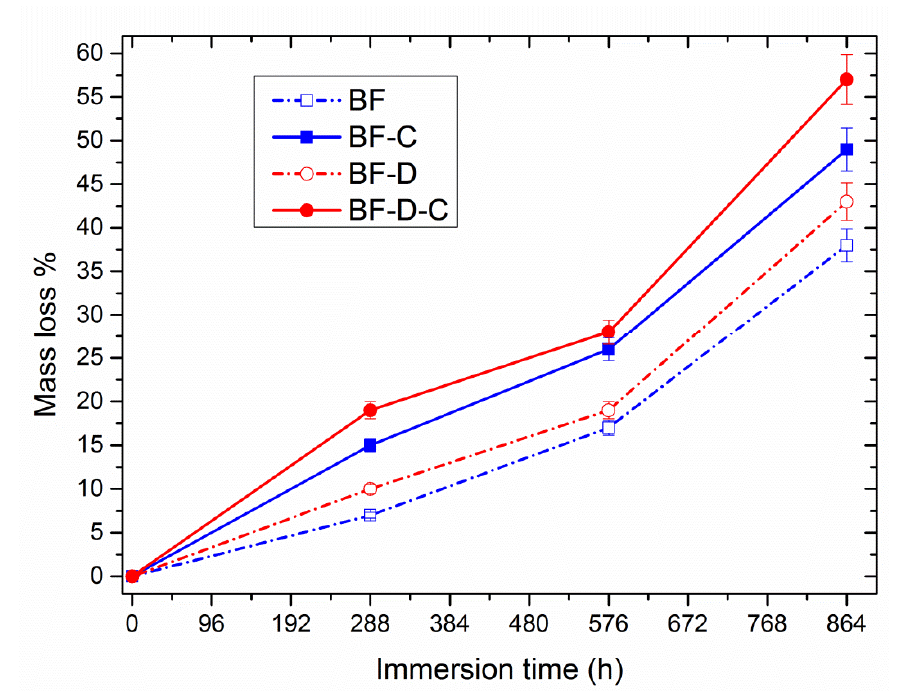
Figure 7. Mass loss percentage of the samples as a function of immersion time.